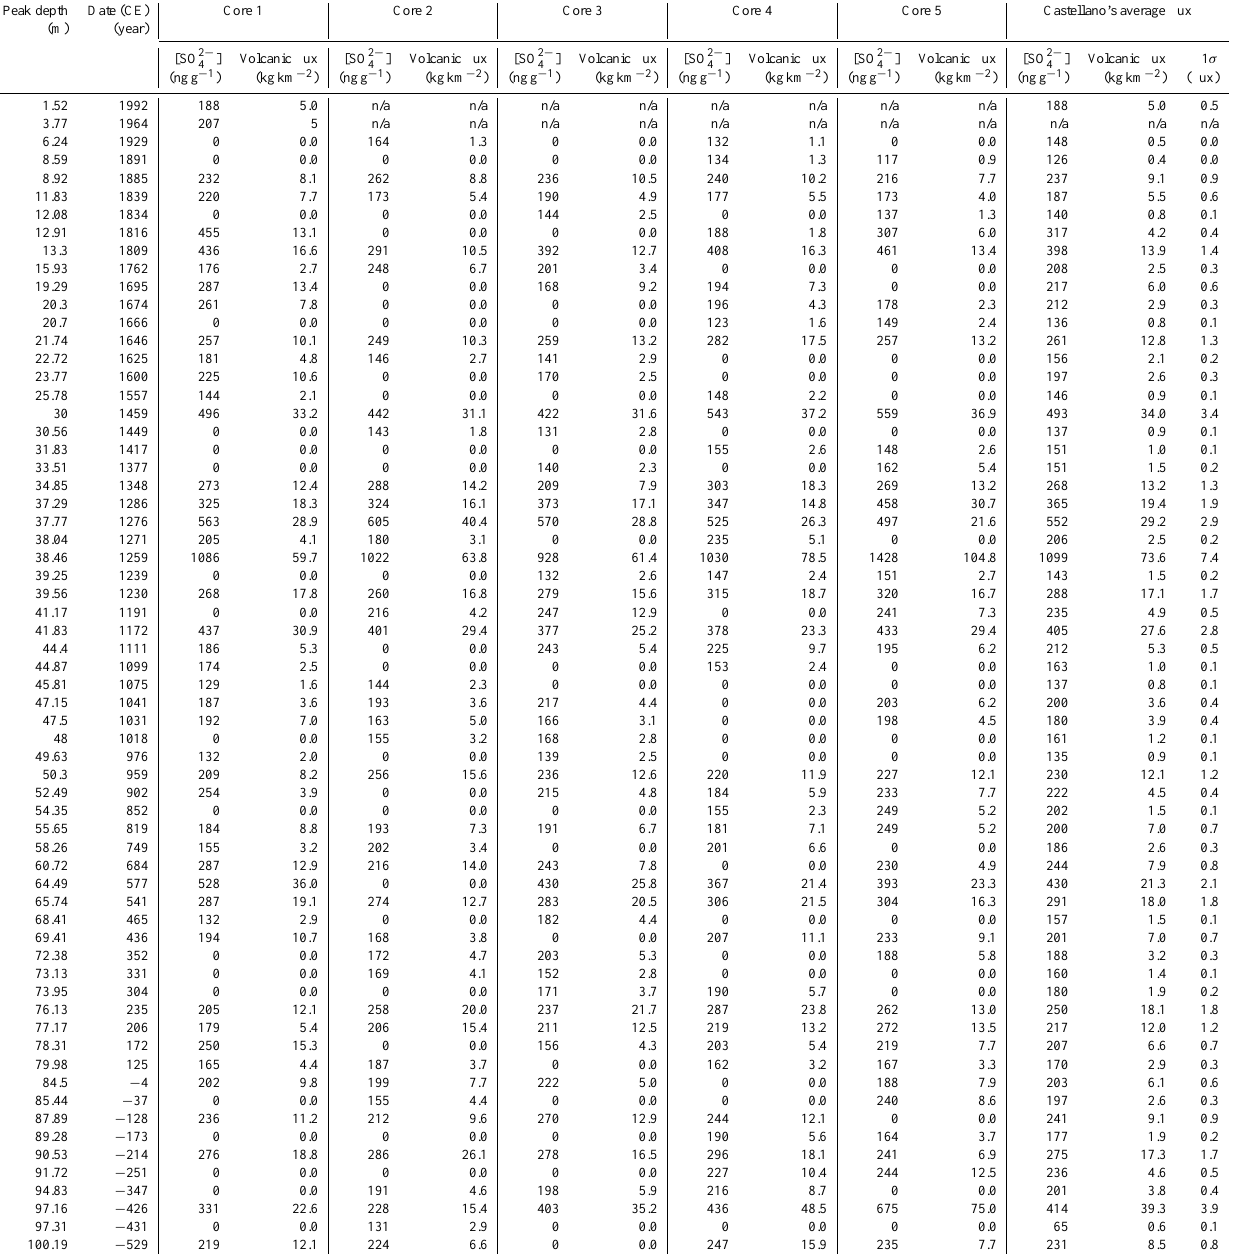
Table 2. Sulfate peaks (maximum concentration in nanograms per gram and flux of volcanic sulfate deposited in kilograms per square kilo- meter) considered to be volcanic eruptions based on the statistical analysis of the five cores. Flux is calculated by integrating the peak, using the density profile obtained during the logging process. Volcanic flux values are corrected from background sulfate (calculated separately for each sulfate peak). Zero stands for non-detected events in the cores. Agung (3.77m) and Pinatubo (1.52m) were not included in the statistical analysis because they were analyzed only in core 1 and thus are marked as not applicable (n/a). The estimation of the average volcanic flux takes into account undetected peaks, for which the flux is considered to be 0. The relative error in the flux (estimated as 10%) takes into account the IC measurement relative standard deviation (below 4% based on standards runs), the error in firn density (relative error estimated as 2%) and the error in sample time length (10%). The last column displays data obtained from Castellano et al. (2005) for identical volcanic peaks. For similar peaks Castellano’s flux generally falls into the average flux + 40% uncertainty, sometimes exceeding this value. Dates are given as CE dates, with negative numbers indicating dates BCE.